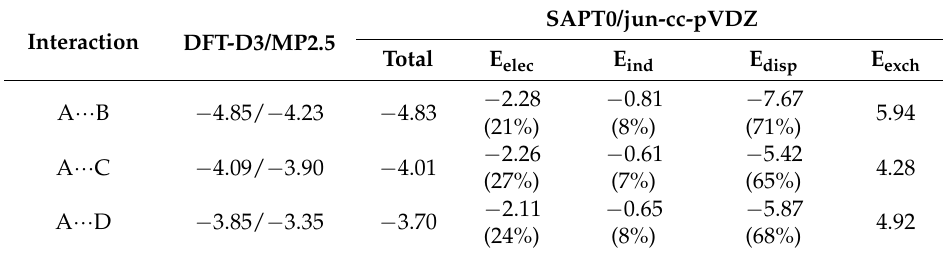
Table 2. Computed DFT-D3/TPSS/TZVPP and MP2.5/CBS two-body interaction energies for